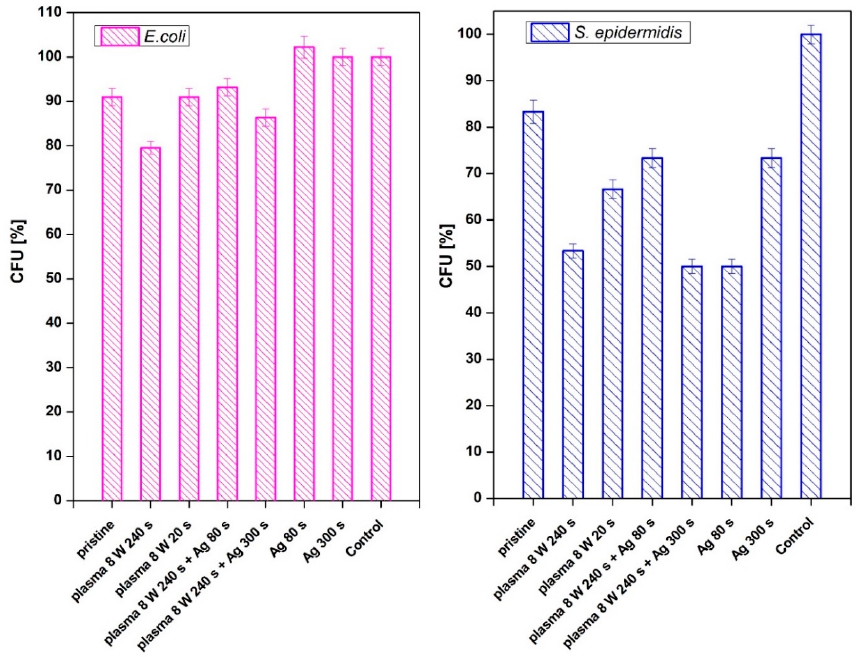
Figure 10. Antimicrobial activity of plasma-activated PTFE further deposited with Ag against bacterial strains of E. coli and S. epidermidis . Plasma treatment was done at 3 and 8 W for 240 s, Ag deposition for 80 and 300 s. The samples were incubated with the bacterial inocula for 2 h and then grown overnight on agar plates, on which the number of colony-forming units (CFU) was determined.